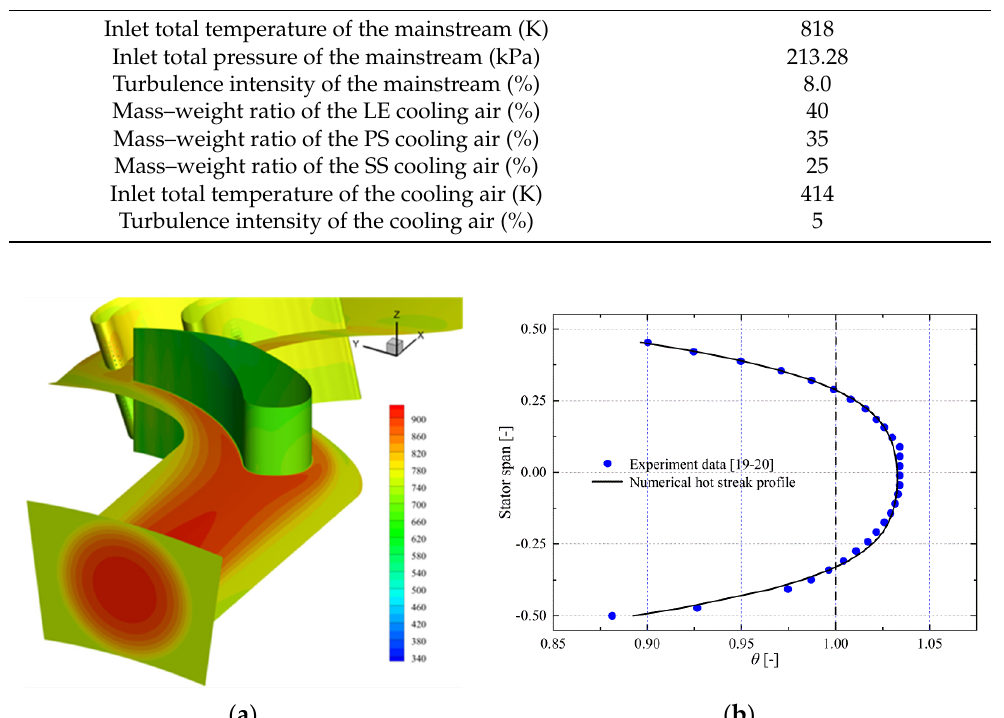
Figure 4. Grid independence test. ( a ) Pressure distribution; ( b ) temperature distribution.